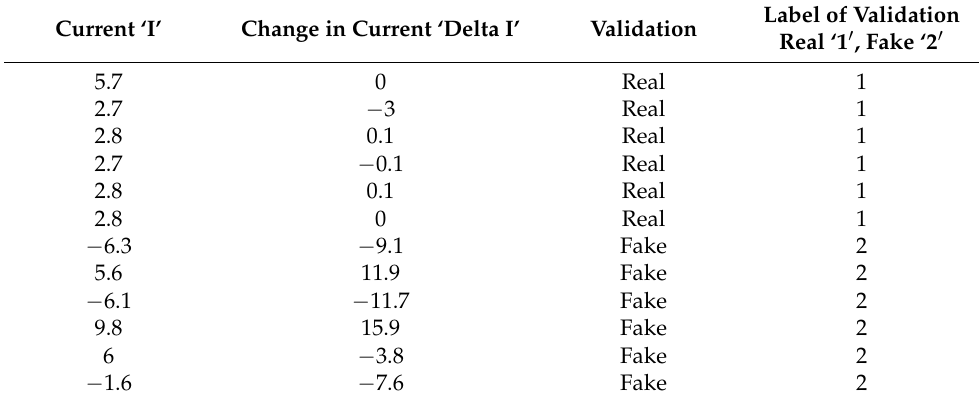
Table 1. Samples of training and testing data of the decision